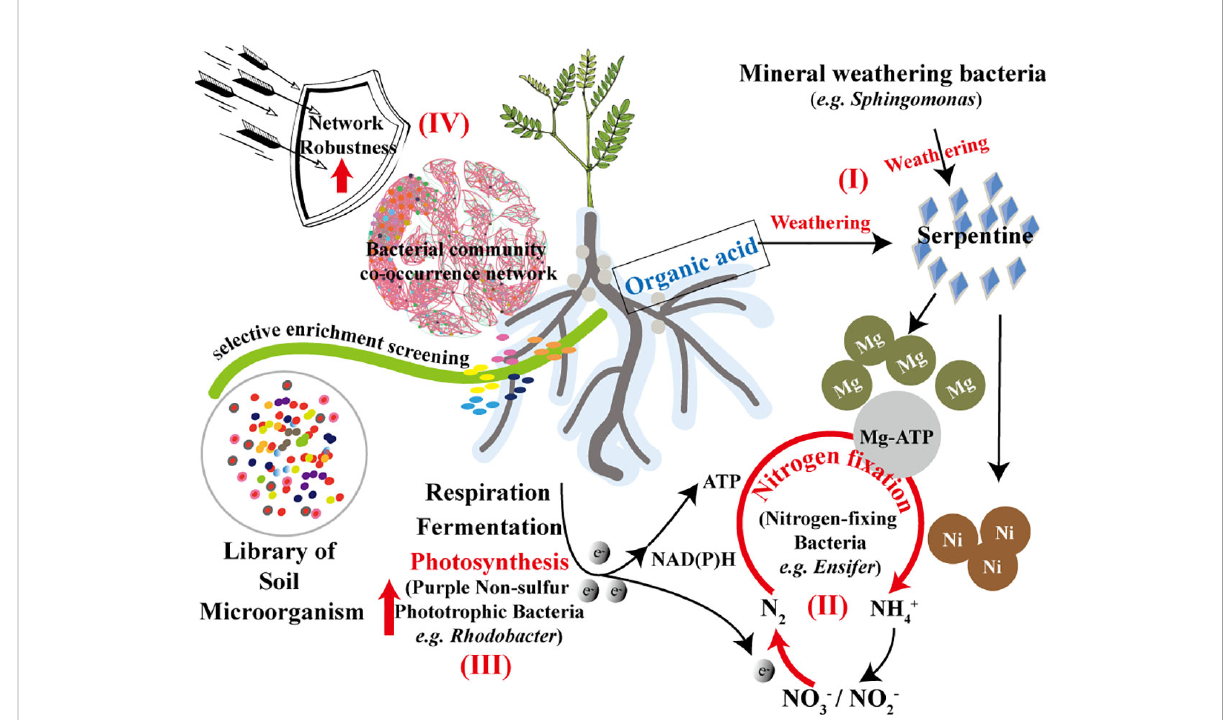
FIGURE 7 Functional prediction analysis of bacterial community selectively enriched in the rhizosphere of S. cannabina grows in CSS treated by application of organic fertilizer combined with river-sand and